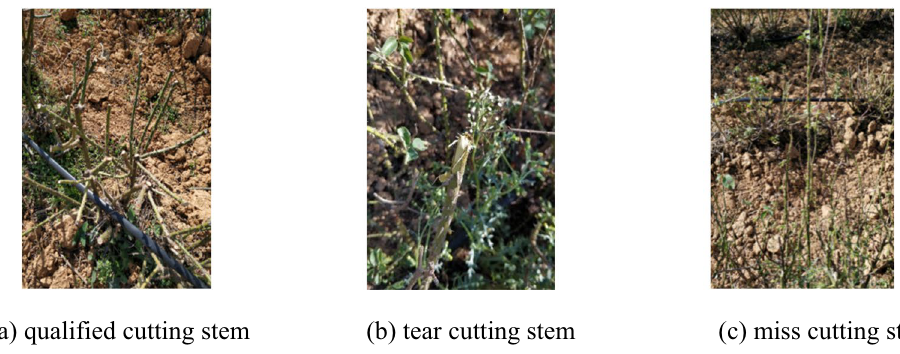
Figure 5. Rose branch status after